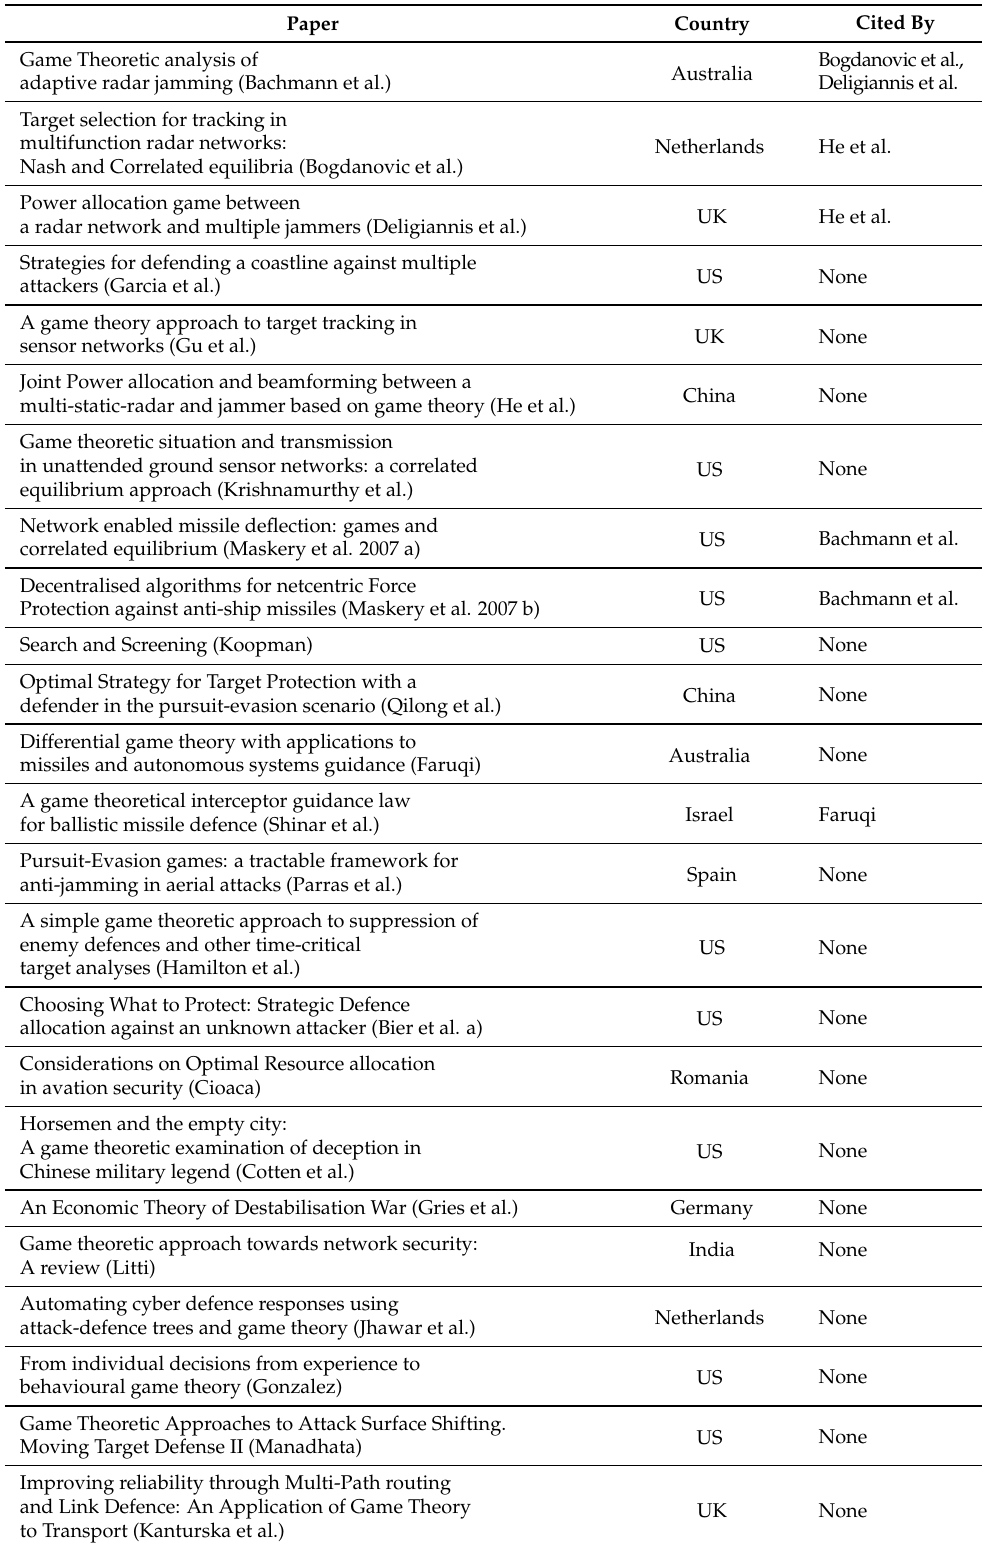
Table 4. Citations among reviewed papers according to Google Scholar. Google Scholar citation data was accessed on 18 December 2021. It is observable from this table that citing each other’s work is extremely rare in the